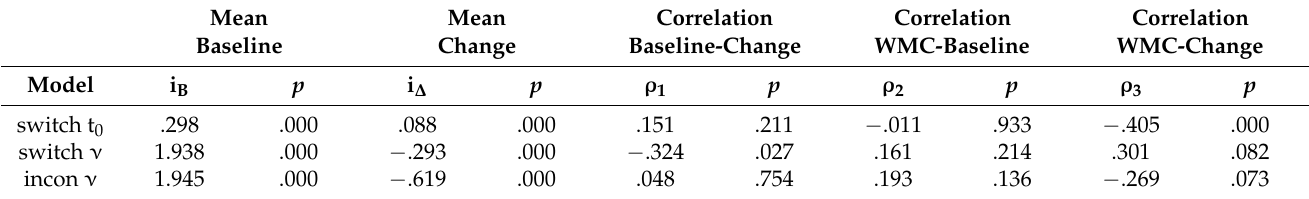
Table 3. Parameter Estimates of LDS models for DM